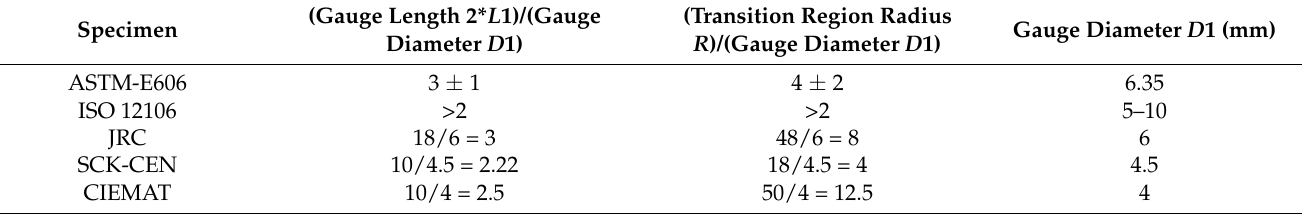
Table 1. Comparison of specimens against the ASTM-E606 and ISO 12106 recommended values.